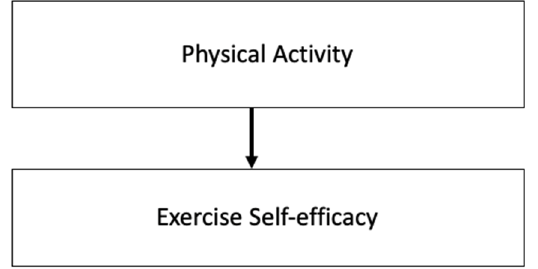
Figure 3. Relationship between Physical Activity and Exercise Self-Efficacy. Note. The figure demonstrate the path from physical activity to exercise self-efficacy, which in line with the original EXSEM.